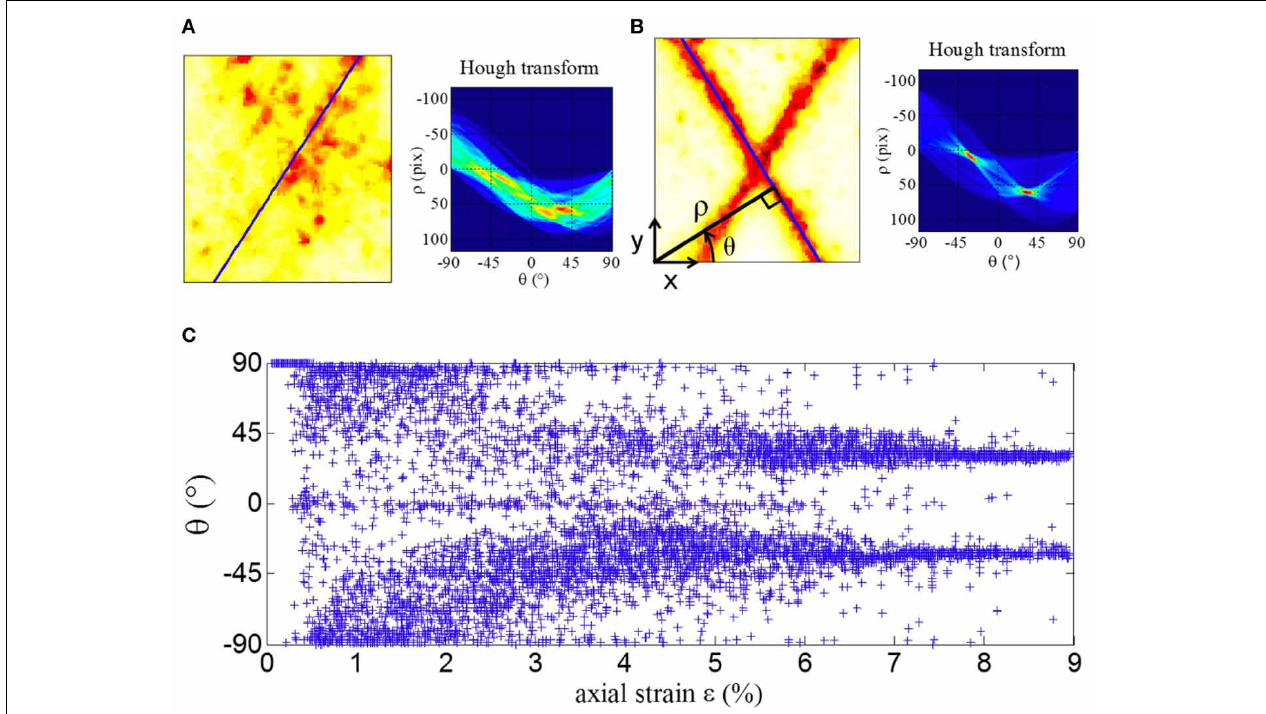
FIGURE 9 | Hough transform of granular material images (Figures 1C–H). (A) Beginning of the loading process (cf Section 3.3). Left : Correlation map. Right: Hough transforms of the correlation map. The contribution of each sinusoid is weighted depending on the value of the correlation of the point of